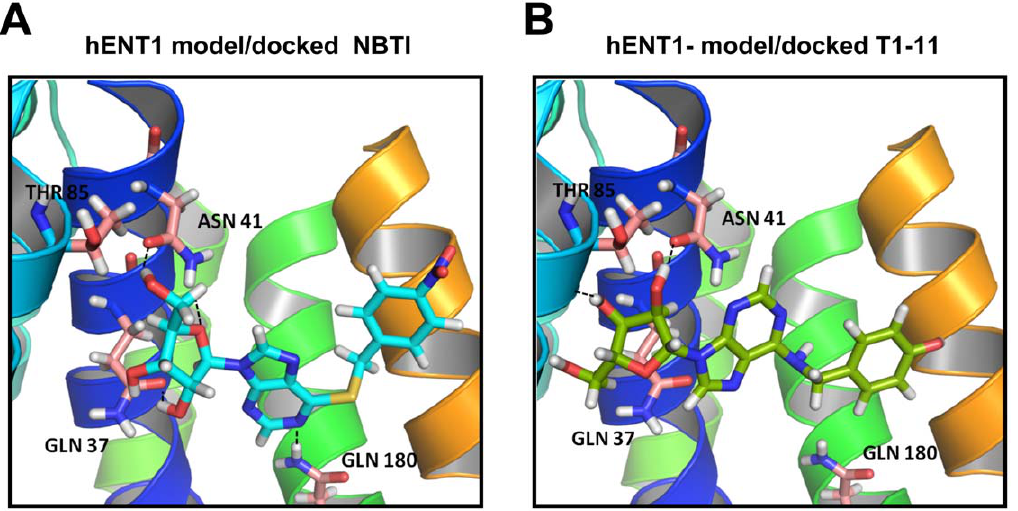
Figure 5. Interactions of inhibitors with ligand binding sites of ENT1. (A) The binding pose of NBTI (a selective inhibitor of ENT1) on human ENT1, as predicted using threading-based ab inito modeling of this transporter. The three-dimensional structure of ENT1 was constructed based on the lactose permease (GlpT) structure. (B) Similar to (A), the binding pose of T1-11 on human ENT1.